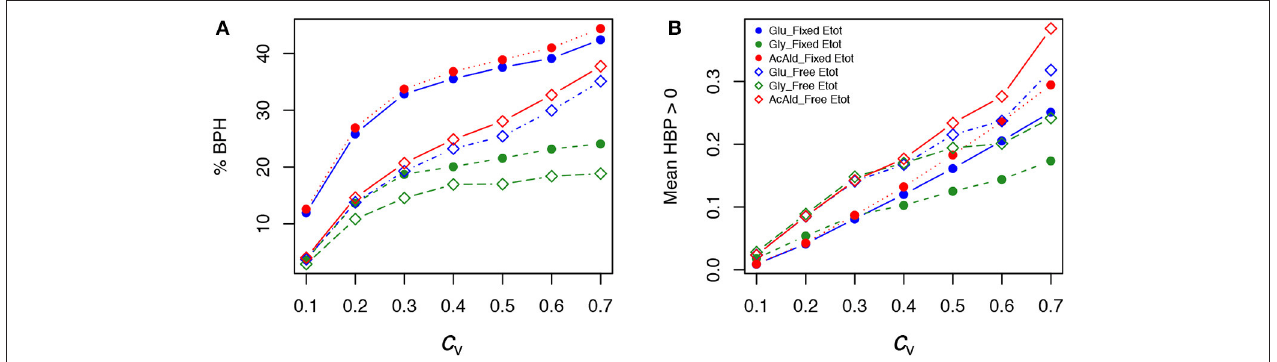
FIGURE 11 | Effect of the coefficient of variation ( c v ) of enzyme concentrations on heterosis in the glycolysis/fermentation network. Percentage of BPH (A) and H + BP (B) over the c v range of parental enzyme